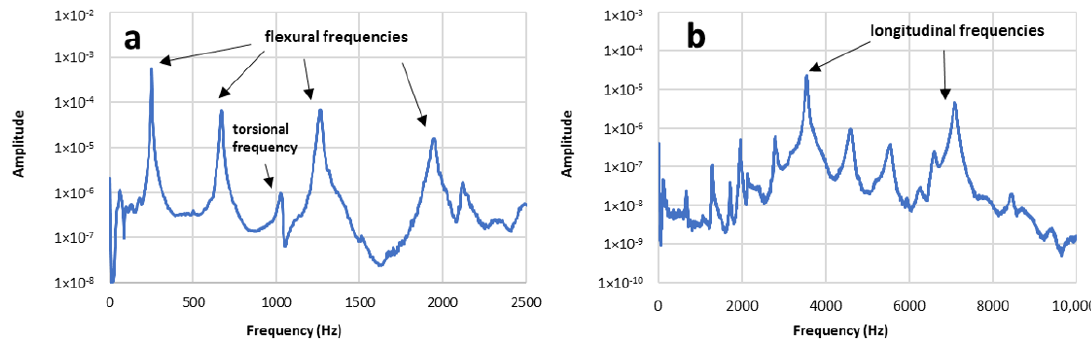
Figure 5. Averaged frequency spectrum for 11A specimen natural vibrations, for a specimen with an angle of − 45 ◦ of the first ply orientation: ( a ) flexural and torsional vibration spectrum. Flexural frequencies were used for out-of-plane modulus of elasticity and in-plane shear modulus determination, while torsional frequency was used for out-of-plane shear modulus determination; ( b ) longitudinal vibration spectrum for in-plane modulus of elasticity